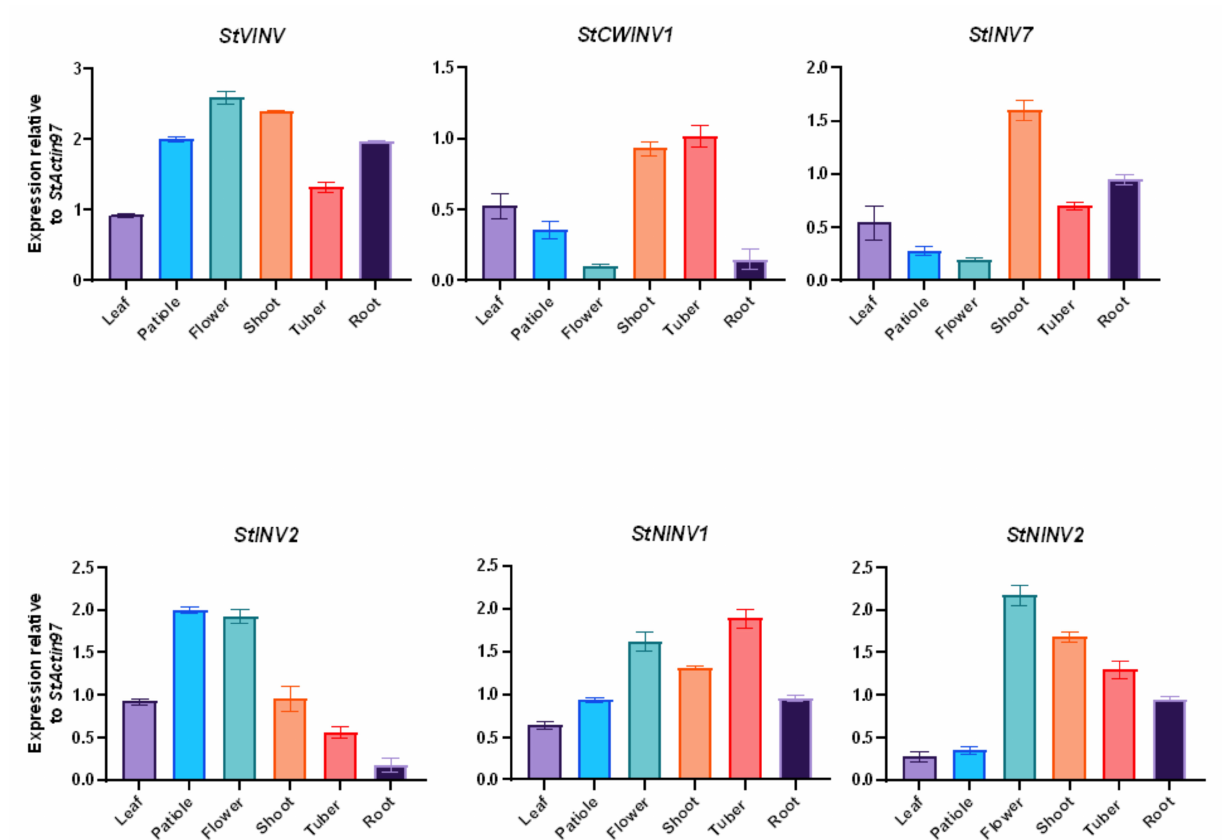
Figure 9. Expression pattern of invertase genes in different tissues. Fold change values are plotted, StActin97 is used as internal control for three biological replicates of each sample in experiment. Bars are drawn for